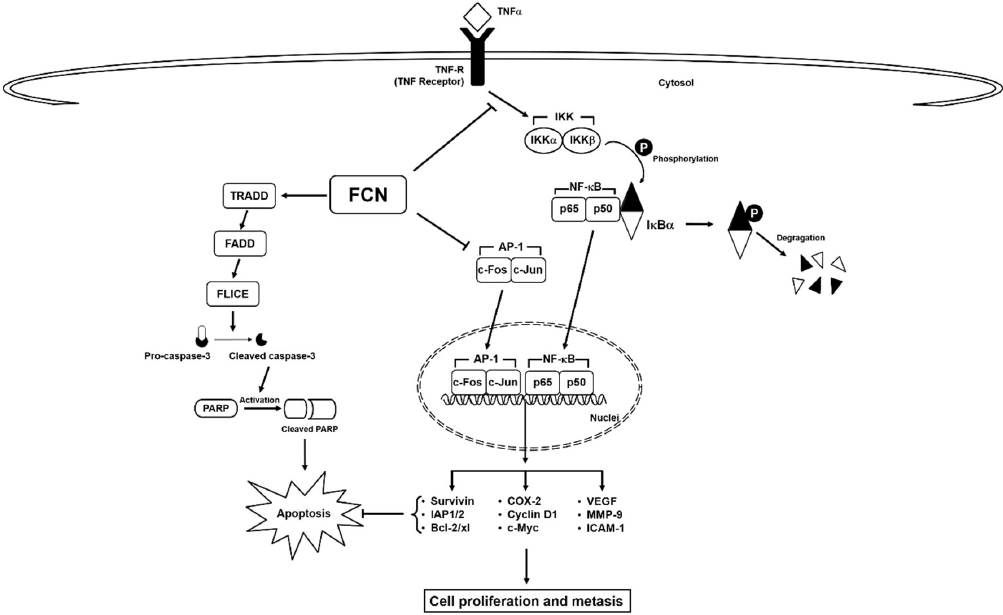
Figure 6. A schematic diagram of FCN effects on NF-κB/AP-1 in tumor cells.